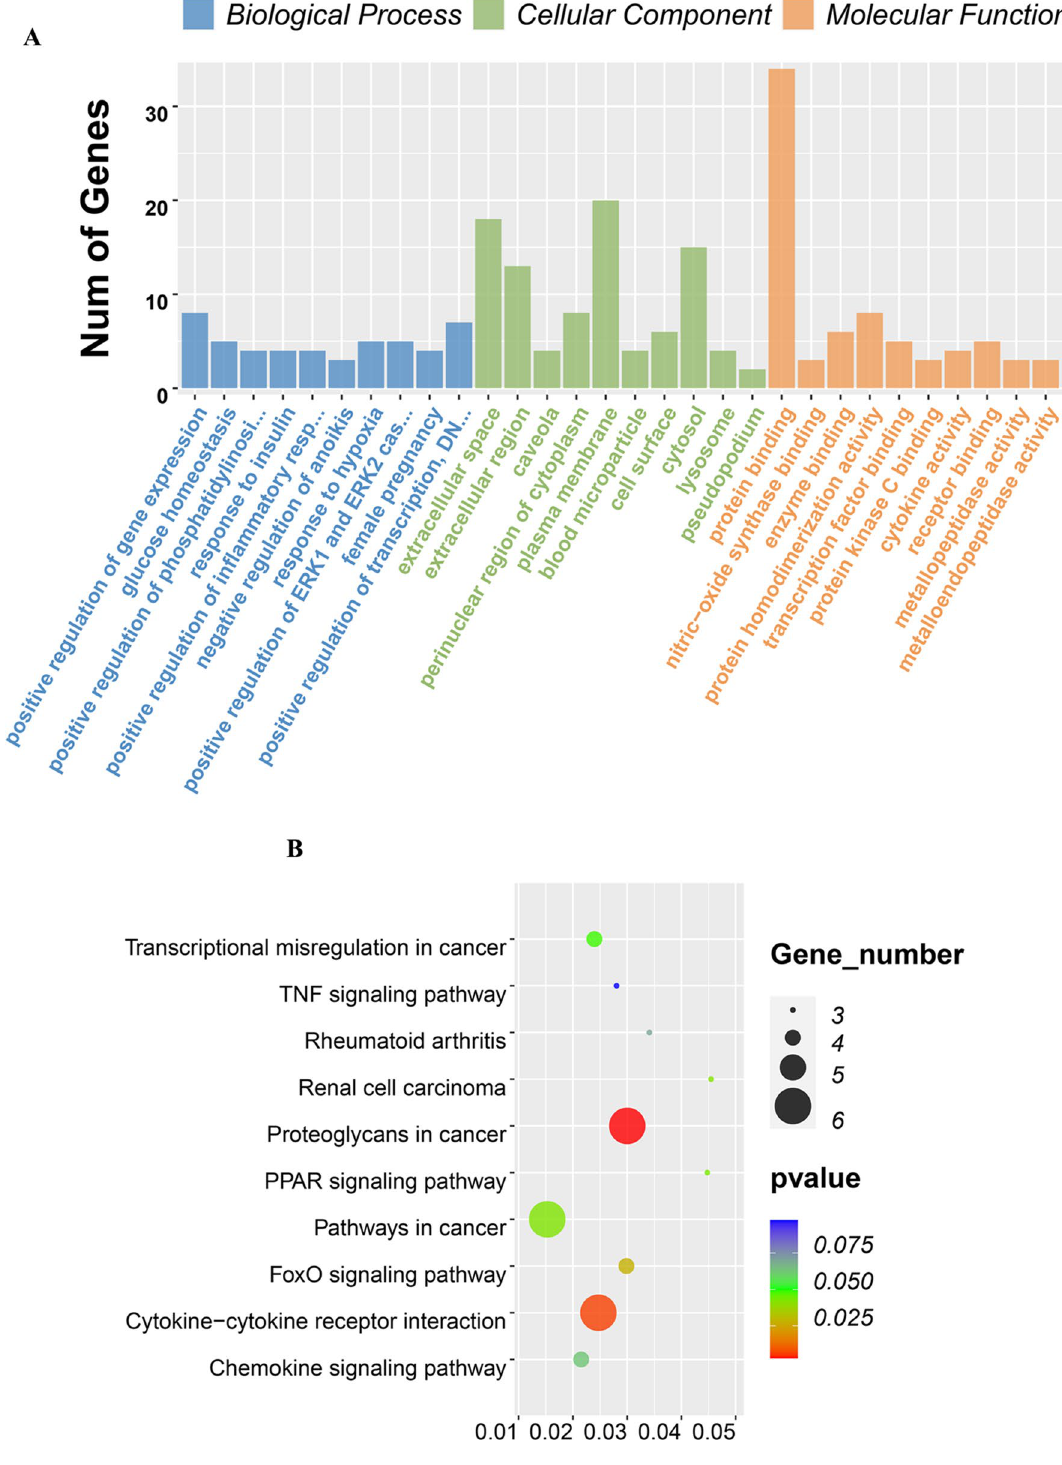
Figure 4. GO term and KEGG pathway analysis for DEGs significantly associated with myocardial infarction and obstructive sleep apnea. ( A) Top 10 GO terms. Number of gene of GO analysis was acquired from DAVID functional annotation tool. p < 0.05. ( B) KEGG